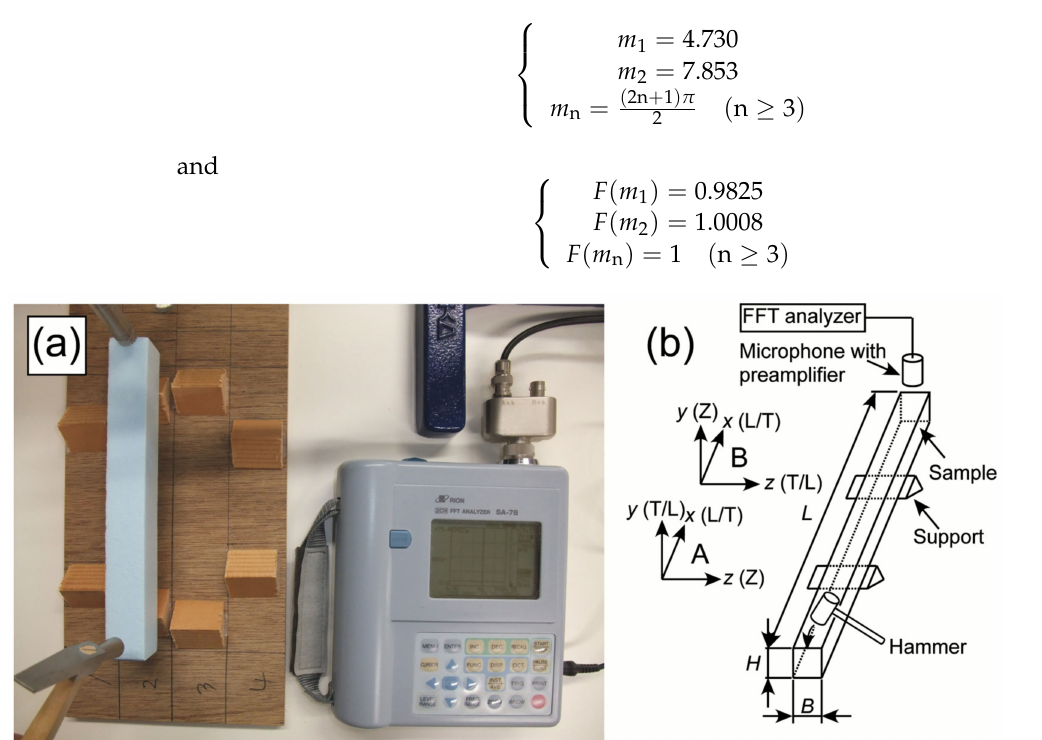
Figure 2. Setup ( a ) and diagram ( b ) of the flexural vibration test. A and B in ( b ) represent the coordi- nate system used for measuring the G LT and G TL values and the G LZ and G TZ values,